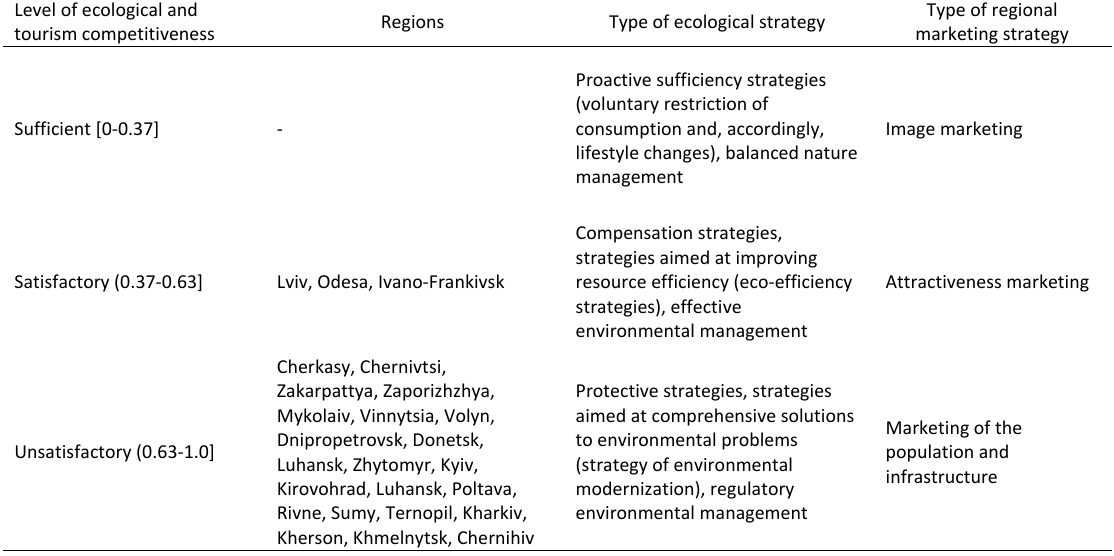
Table 5: Ecological and marketing strategy for the development of green tourism potential (case in 2020) Level of ecological and Regions tourism competitiveness